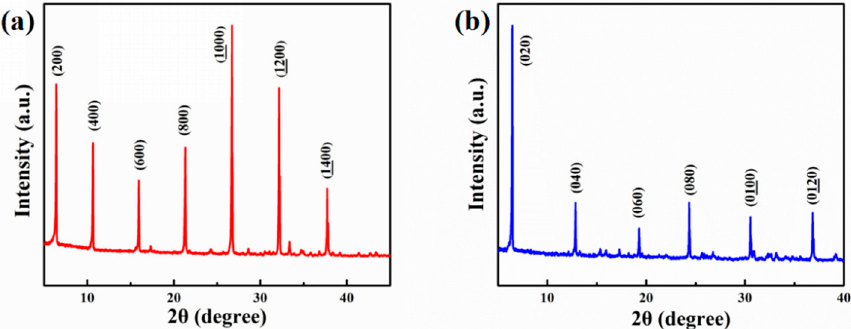
Figure 3. The XRD patterns of the perovskite powders ( a ) (C 6 H 5 CH 2 NH 3 ) 2 PbBr 4 ; ( b ) (C 6 H 5 CH 2 NH 3 ) 2 PbI 4 .